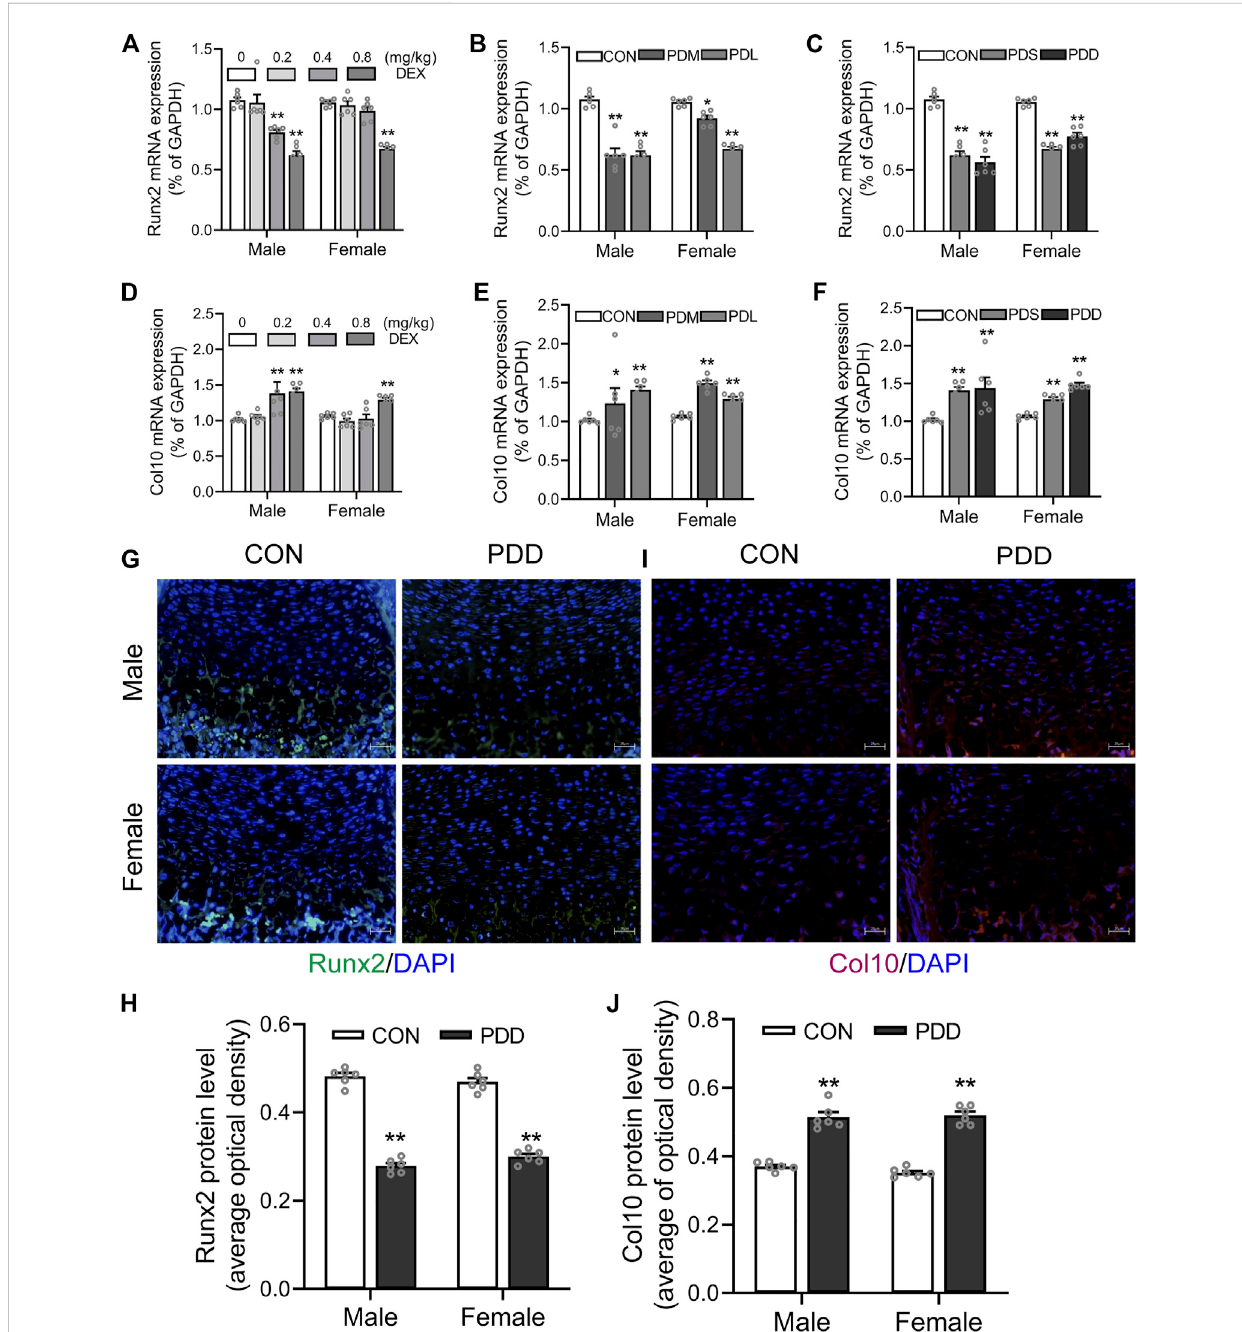
Effects of different doses, stages, and courses of dexamethasone exposure during pregnancy on the Runx2 and Col10 expression in growth plate cartilage. (A) . The mRNA expression of Runx2 in different doses of dexamethasone group; (B) . The mRNA expression of Runx2 in different stages of dexamethasone group; (C) . The mRNA expression of Runx2 in different courses of the dexamethasone group; (D) . The mRNA expression of Col10 in different doses of the dexamethasone group; (E) . The mRNA expression of Col10 in different stages of dexamethasone group; (F) . The mRNA expression of Col10 in different courses of dexamethasone group; (G) . Typical immuno fl uorescence images of Runx2 in fetal bone tissue; (H) . Typical immuno fl uorescence images of Col10 in fetal bone tissue; (I) . The protein level of Runx2 in different courses of dexamethasone group; (J) . The protein level of Col10 in different courses of the dexamethasone group. * p < 0.05 , **p < 0.01 , Control v.s. dexamethasone treatment group. CON, control; PDS,